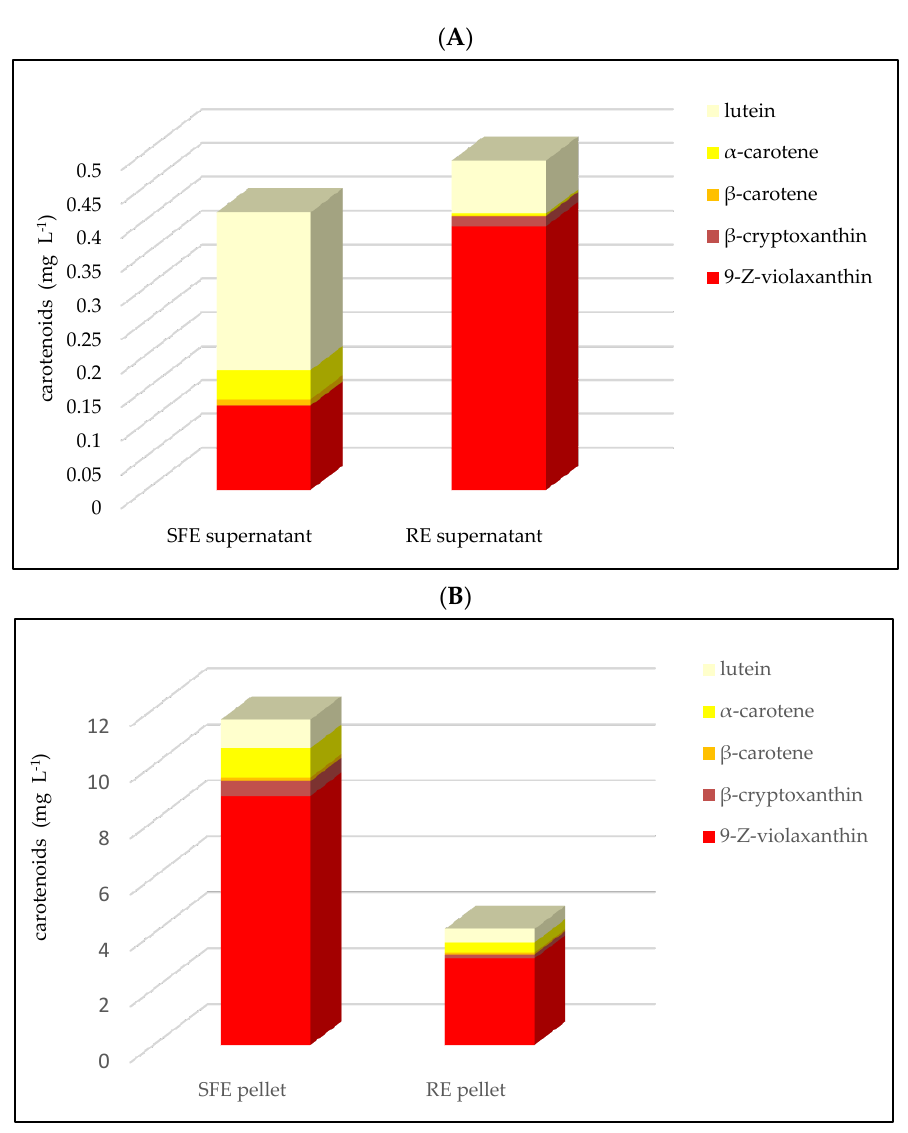
Figure 4. Carotenoid concentration in “Valencia” orange juice processed with shear force extractor (SFE) and reamer extractor (RE) types. ( A ): supernatant; ( B ): pellet.